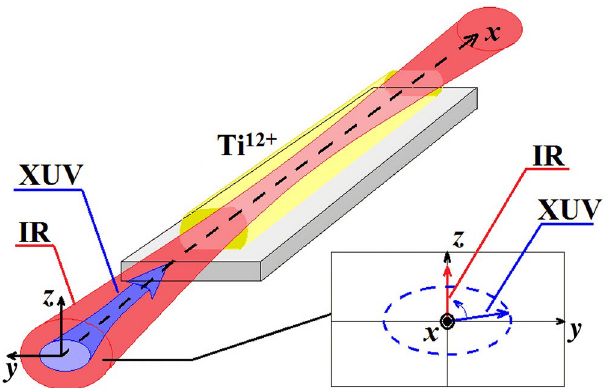
Figure 1. A sketch of the model considered in the paper. The pre-created plasma active medium (yellow truncated cylinder) is irradiated by a combination of a strong IR field (red beam) and a set of its high-order harmonics (the XUV radiation, violet beam), which overlap in space and time and co-propagate along the axis of the plasma channel ( x -axis). The IR field is linearly polarized along z -axis, while the XUV beam has an arbitrary elliptical polarization in yz -plane.